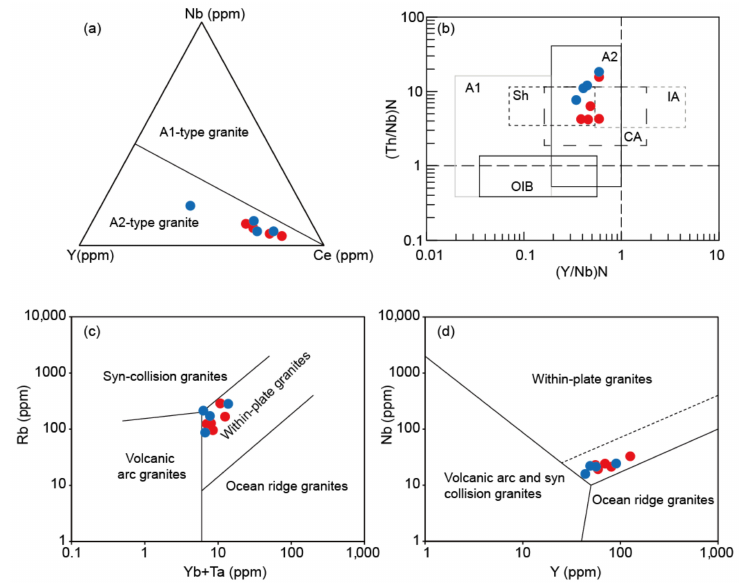
Figure 12. ( a ) Subdivision diagram for A-type granites [46]. ( b ) (Th/Nb) N and (Y/Nb) N diagram for subdivision of A-type granites [52]. ( c ) Rb versus Yb + Ta tectonic discrimination diagram [51]. ( d ) Nb versus Y tectonic discrimination diagram [51]. Abbreviations: A1—A1-type granitoids, A2—A2- type granitoids, Sh—shoshonites, IA—Island Arcs, CA—Continental Arcs, OIB—Ocean Island Basalts. Normalization (N) value of silicate earth after [54]. The symbols are the same as those in Figure